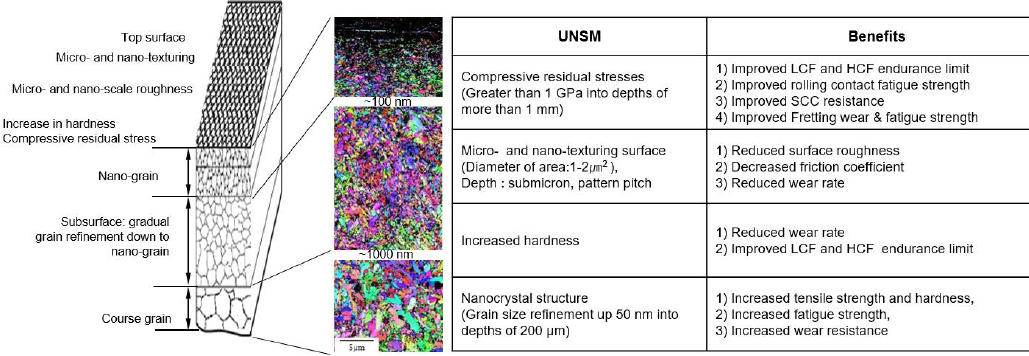
Figure 5. Mechanism and industrial applications of the UNSM process.